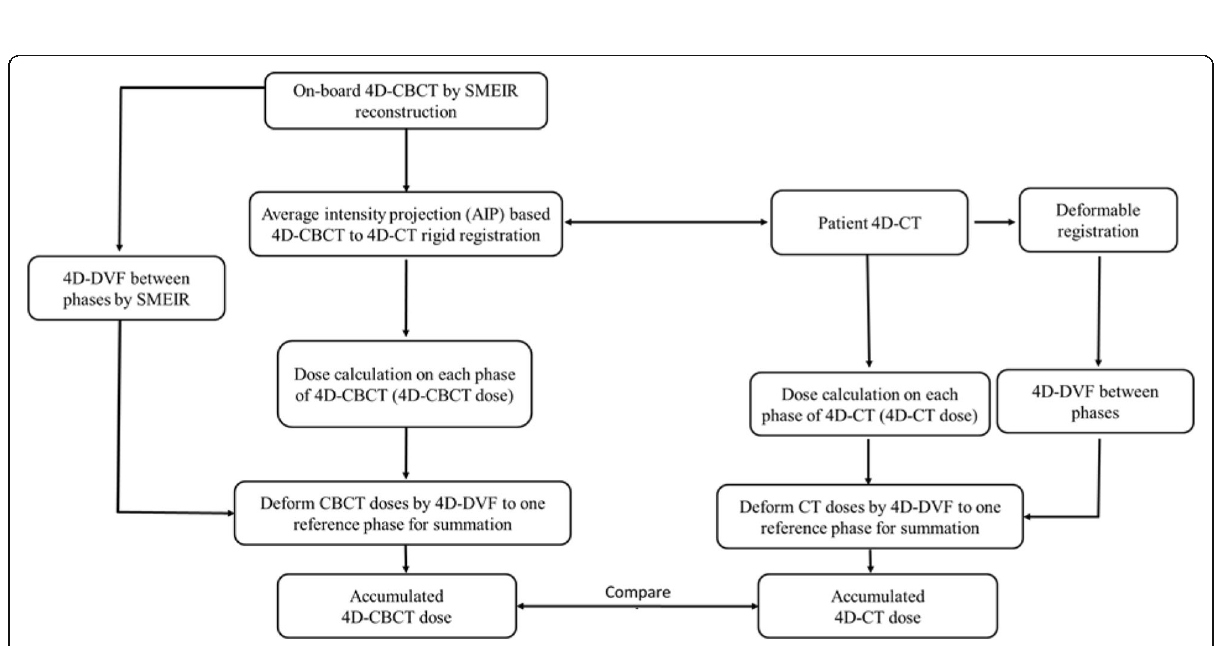
Fig. 9 Proposed SMEIR-driven 4D dose accumulation and evaluation workflow for radiation oncology. After applying the rigid registration to align the 4D-CBCT to the 4D-CT coordinates, the 4D-CBCT uses the DVFs solved by SMEIR to deform 4D doses to a single reference phase, in a similar way as the dose accumulation process of 4D-CT. The 4D-CT uses a direct deformable registration algorithm to derive inter-phase DVFs, since the high-quality CT images allow direct inter-phase DVF solution. 4D-CBCT: 4-Dimensional cone-beam computed tomography; SMEIR: Simultaneous motion estimation and image reconstruction; DVF: